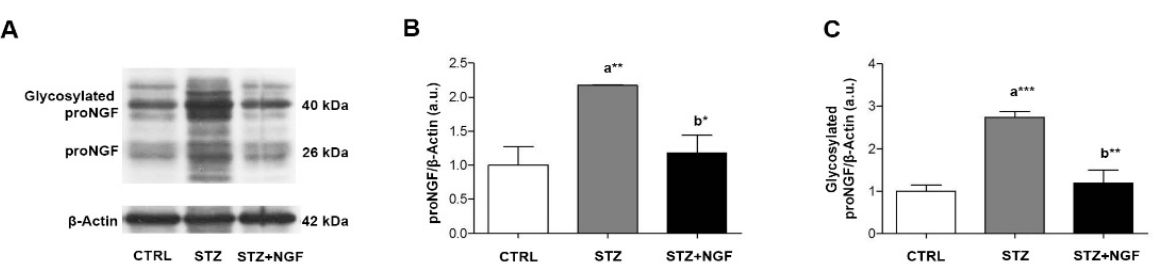
Figure 7. ( A – C ). Glycosylated and non-glycosylated proNGF levels in diabetic retina before and after ocular NGF treatment. Altered proNGF levels are shown by Western Blot ( A ) and densitometric analyses ( B , C , respectively). β -Actin expression was used to normalize sample variability, a.u. indicates arbitrary units. The results are expressed as mean ± SD. Statistical significance is indicated with * p < 0.05, ** p < 0.01, *** p < 0.001. “a” vs. CTRL group; “b” vs. STZ group. CTRL, healthy rats; STZ, streptozotocin; STZ+NGF, streptozotocin+nerve growth factor eye